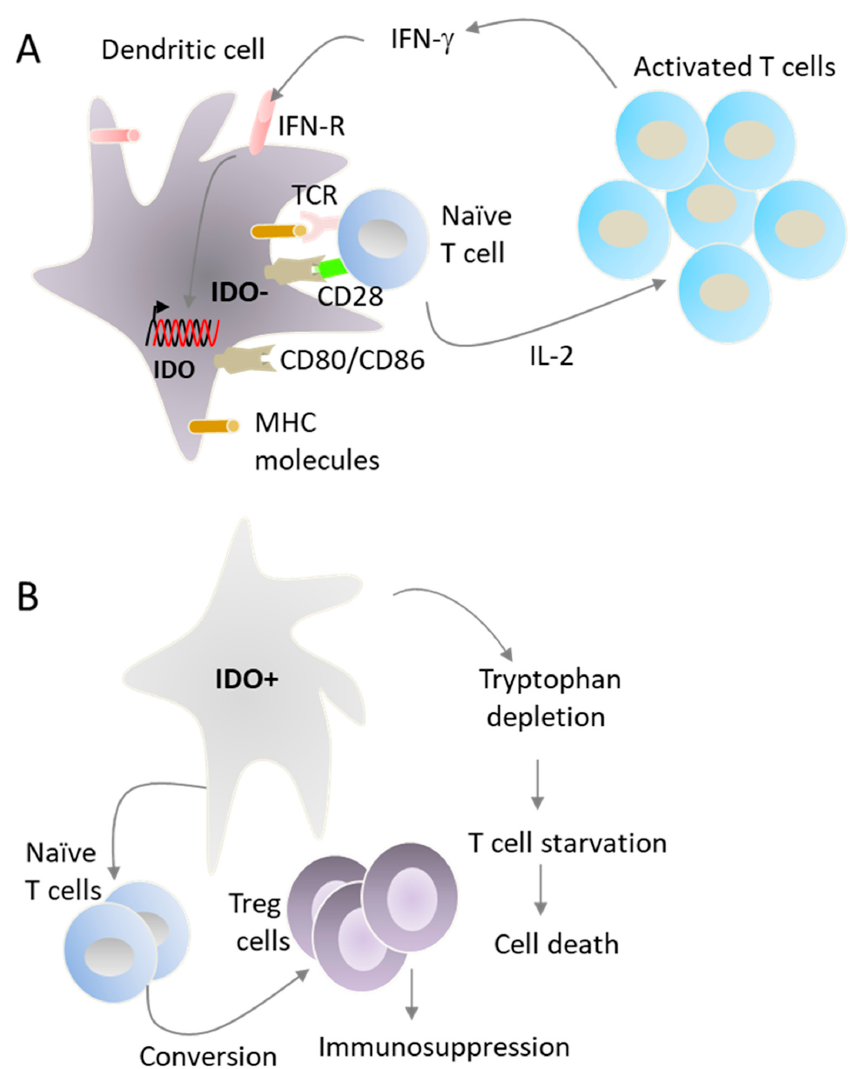
Figure 4. DCs control the duration of antigen-specific immune response. DCs process proteins into antigenic peptides that are presented on major histocompatibility (MHC) molecules to T cells ( A ). The recognition of MHC-peptide complexes by T cells induces antigen-specific signaling via the T cell receptor TCR, known as signal 1. This activation is amplified by the interaction between the co-stimulatory molecules CD80 and CD86 on DC surface with CD28 on T cell surface, known as signal 2, which induces the expression of IL-2. IL-2 facilitates T cell proliferation and clonal expansion. IL-12 produced by DCs promotes the activation of T cells to produce IFN- γ , which favors the generation of CTLs and enhances the activation of cytotoxic NK cells. IFN- γ also induces the expression of IDO by DCs, resulting in their conversion into tolerogenic DCs ( B ). In general, IDO+ DCs polarize naïve T cells into Treg cells, a population of CD4+ T cells that inhibits, rather than promotes, immune responses. Moreover, IDO expressing DCs convert tryptophan into toxic metabolites with immunosuppressive activity on